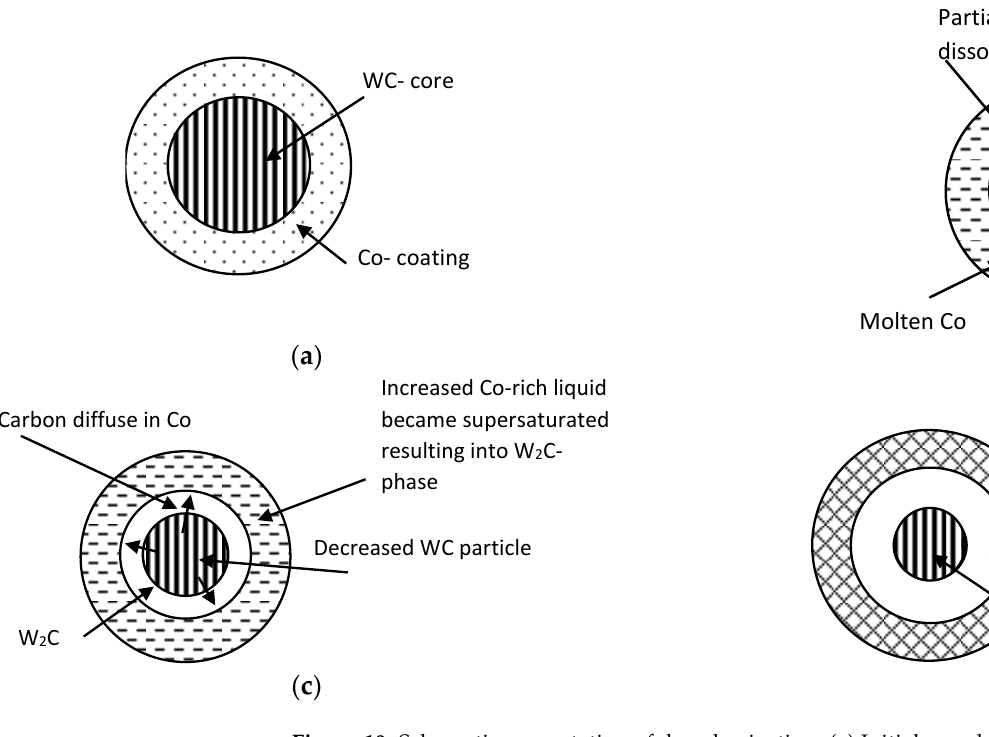
Figure 10. Schematic presentation of decarburization. ( a ) Initial powder structure composed of WC particle covered with Co-binder. ( b ) Powder during flight where the binder melts and WC dissolute. ( c ) Phase of cooling down and decarburization. ( d ) Solidification of molten binder upon reaching the substrate.